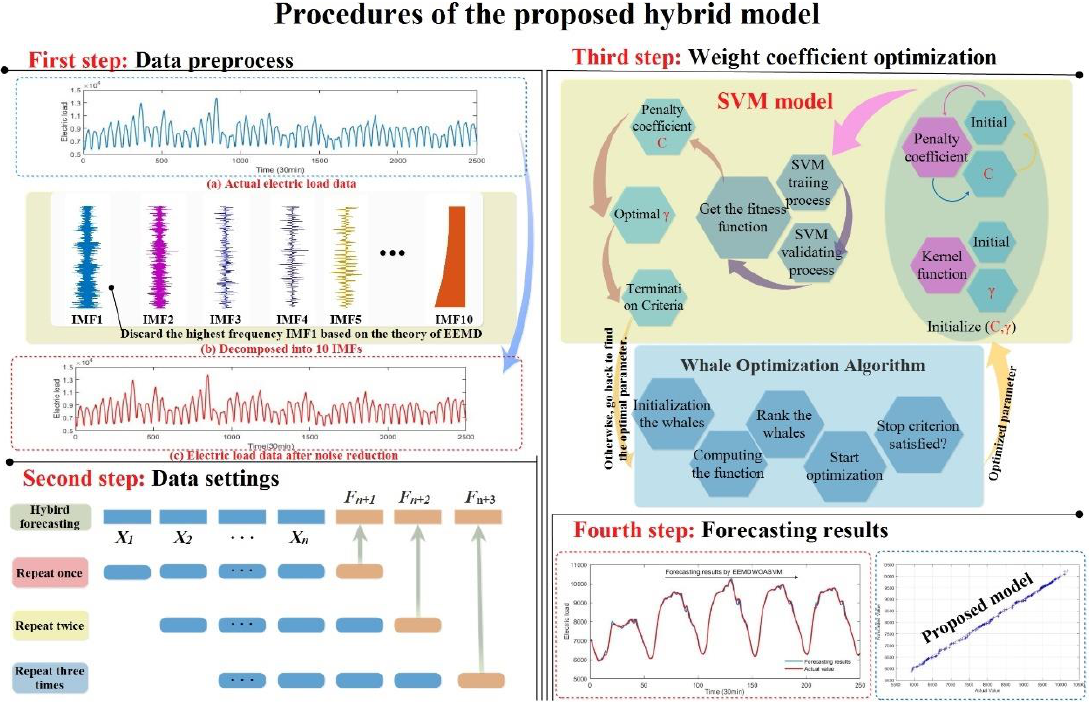
Figure 1. Procedures of the proposed Ensemble Empirical Mode Decomposition-Whale Optimization Algorithm-Support Vector Machine (EEMD-WOA-SVM) model.